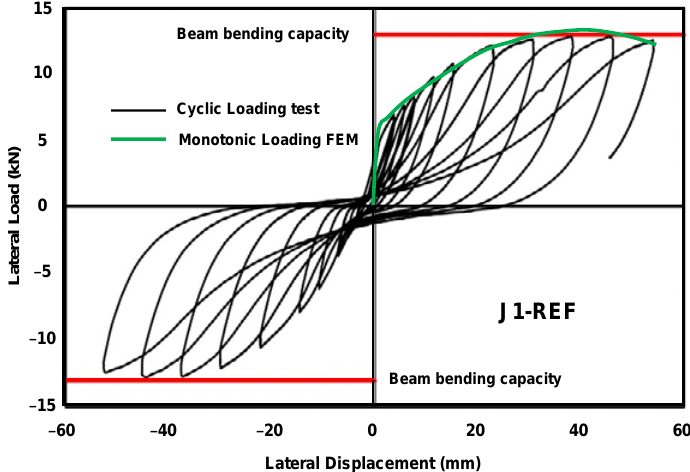
Figure 9. Load-displacement curves of experiment and numerical analysis. Buildings 2021 , 11 , x FOR PEER REVIEW 9 of 15